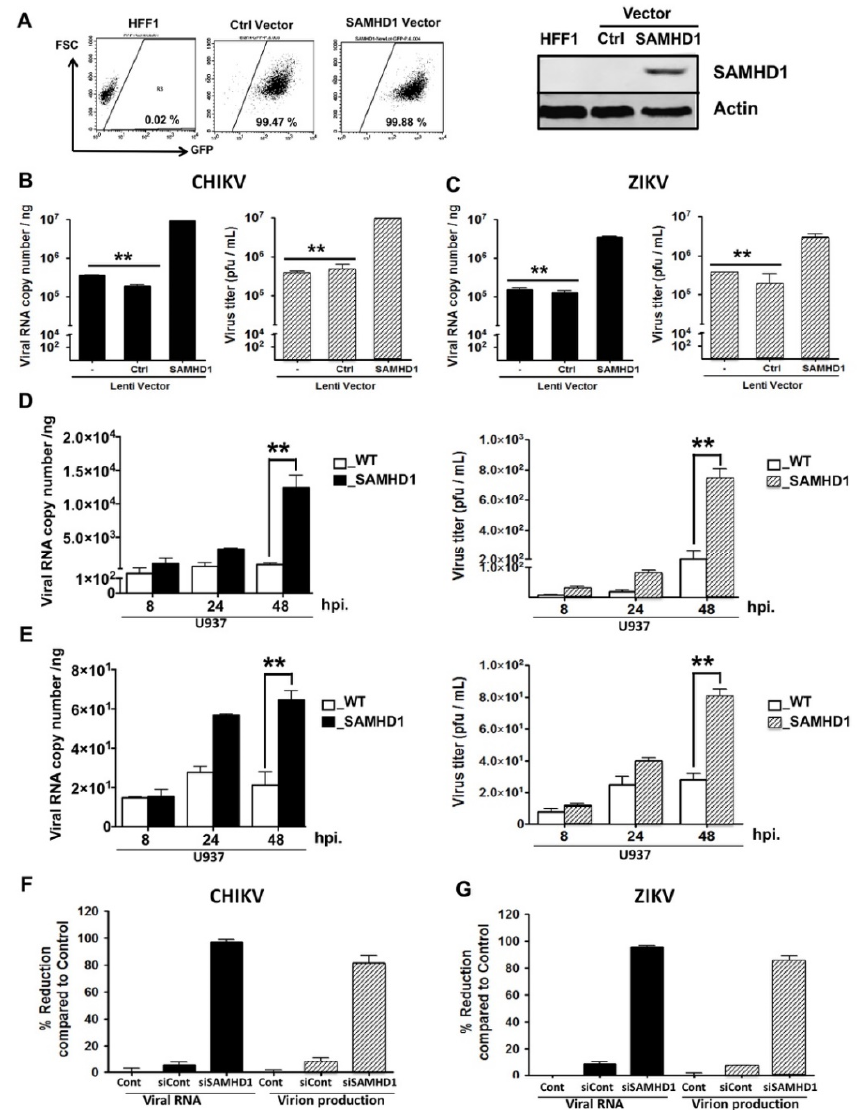
Figure 5. SAMHD1 over-expression enhances CHIKV and ZIKV replication. ( A ) HFF1 cells were transduced by either control (Ctrl)- or SAMHD1-GFP lentiviral vector. Transduced cells were sorted by a FACSAria III cytometer and obtained cell lines were validated for GFP expression by flow cytometry (10,000 single cell events in the analysis gate) and for SAMHD1 expression using Western blotting analysis. ( B , C ) Untreated ( − ), control transfected (Ctrl) or SAMHD1-(SAMHD1) transfected HFF1 cells were infected with CHIKV or ZIKV at MOI 1. At 48 hpi, intracellular viral RNA was quantified by RT-PCR (black bars); virus titers were measured using a plaque assay (gray bars). ( D , E ) Wild type U937 cells (WT) or U937 cells expressing SAMHD1, were infected with CHIKV or ZIKV at MOI 1. At 8, 24 and 48 hpi, the intracellular viral RNAs was quantified by RT-PCR (black bars); virus titers were measured by plaque assay (gray bars). ( F , G ) Amounts of CHIKV and ZIKV RNA and infectious virion production were determined at 24 hpi in HFF1 cells that were mock-transfected (Cont) or transfected, either with control siRNA (siCont) or siRNA specific for SAMHD1 (siSAMHD1). Expression of viral RNA and viral titers were quantified using real time RT-PCR (black bars) or plaque assay (gray bars), respectively. Percentage of reduction was calculated for each of the experimental conditions (siCont and siSAMHD1) using the formula [1 − (R/C)] × 100, where C and R designate experimental values (RNA copy numbers or plaque numbers) in untreated cells and siCont- or siSAMHD1-treated cells, respectively. The data represent the mean values ± SD from three independent experiments. ** p -value < 0.01 as compared to control cells.